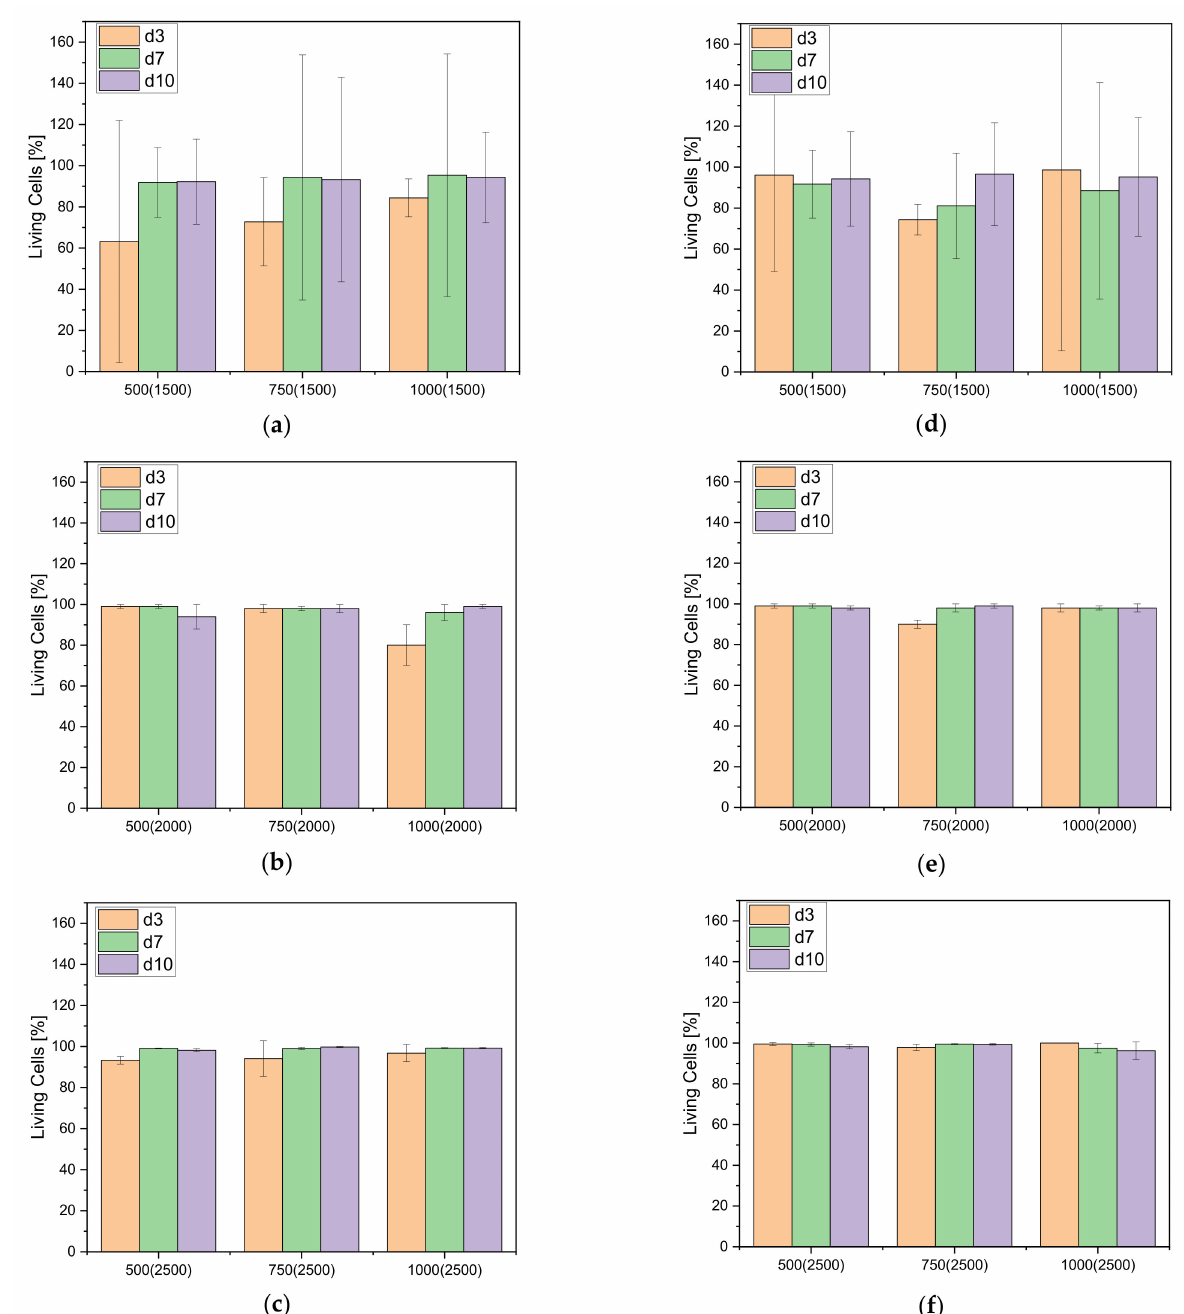
Figure 9. Living Cells in percent for the different band widths after 3, 7 and 10 days; Overview for the ( a ) 1500 µ m band width; outer surface; ( b ) 2000 µ m band width, outer surface; ( c ) 2500 µ m band width, outer surface; ( d ) 1500 µ m band width, inner surface; ( e ) 2000 µ m band width, inner surface; ( f ) 2500 µ m band width, inner